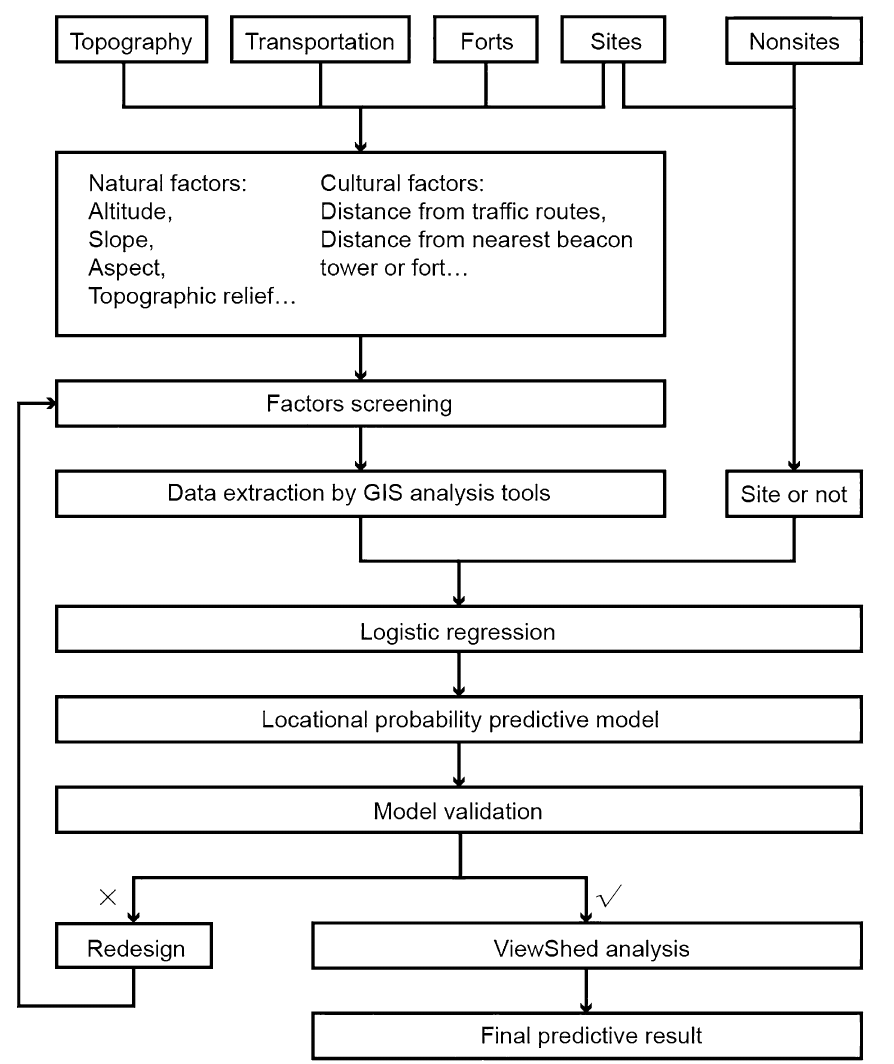
Figure 2. Working flow chart for the prediction of beacon sites in Wenzhou.